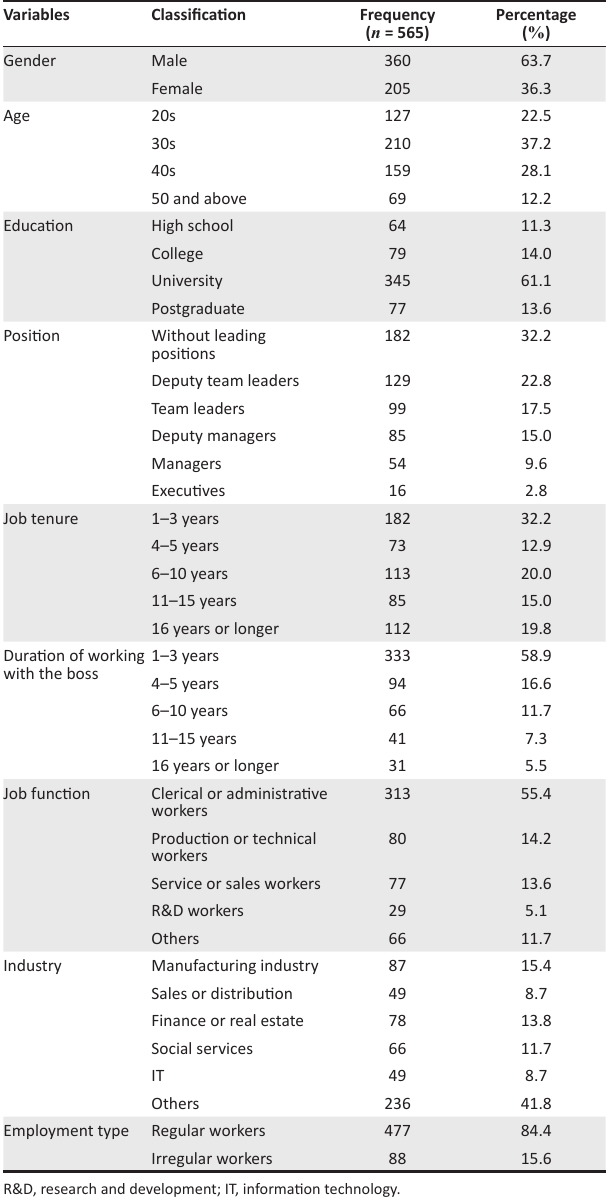
TABLE 1: Descriptive statistics of variables. Variables